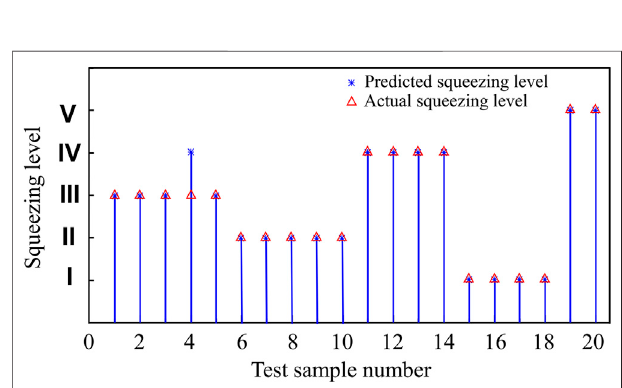
FIGURE 5 | PNN prediction results on the test